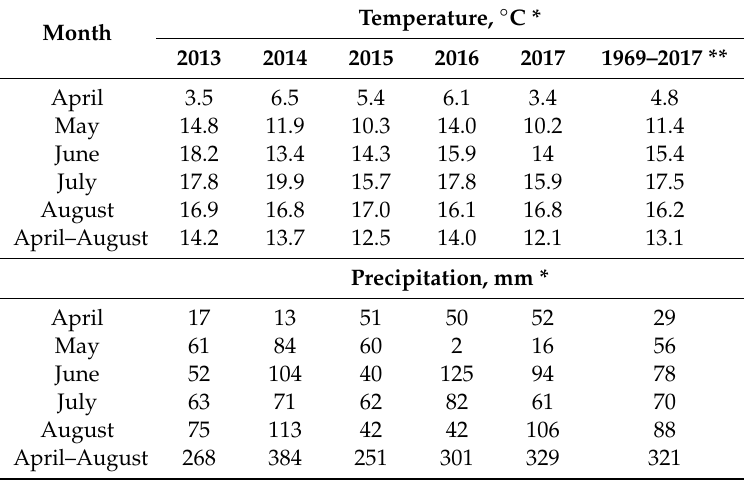
Table 1. Monthly average temperature ( ◦ C) and total precipitation (mm) in 2013–2017 compared with the long-term average